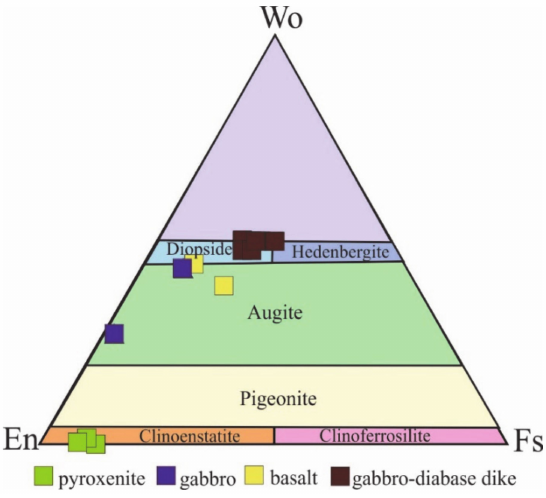
Figure 8. A pyroxene nomenclature diagram